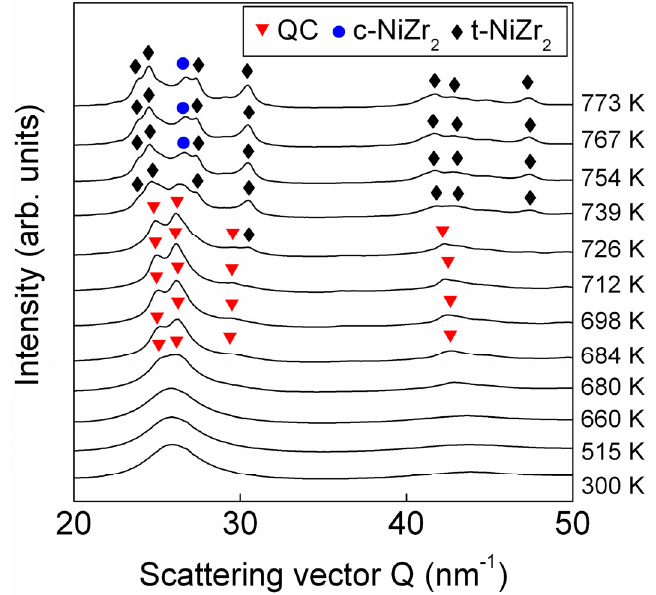
Figure 2. XRD patterns ( λ = 0.01249 nm) of the as-cast Zr metallic glass as a function of